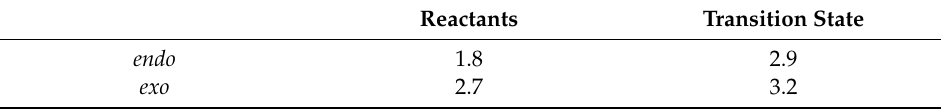
Table 2. Number of Solute-Solvent Interactions for the Reactants and Transition State Integrating from − 10.0 to − 3.0 kcal / mol from quantum mechanics and molecular mechanics (QM / MM) FEP / MC